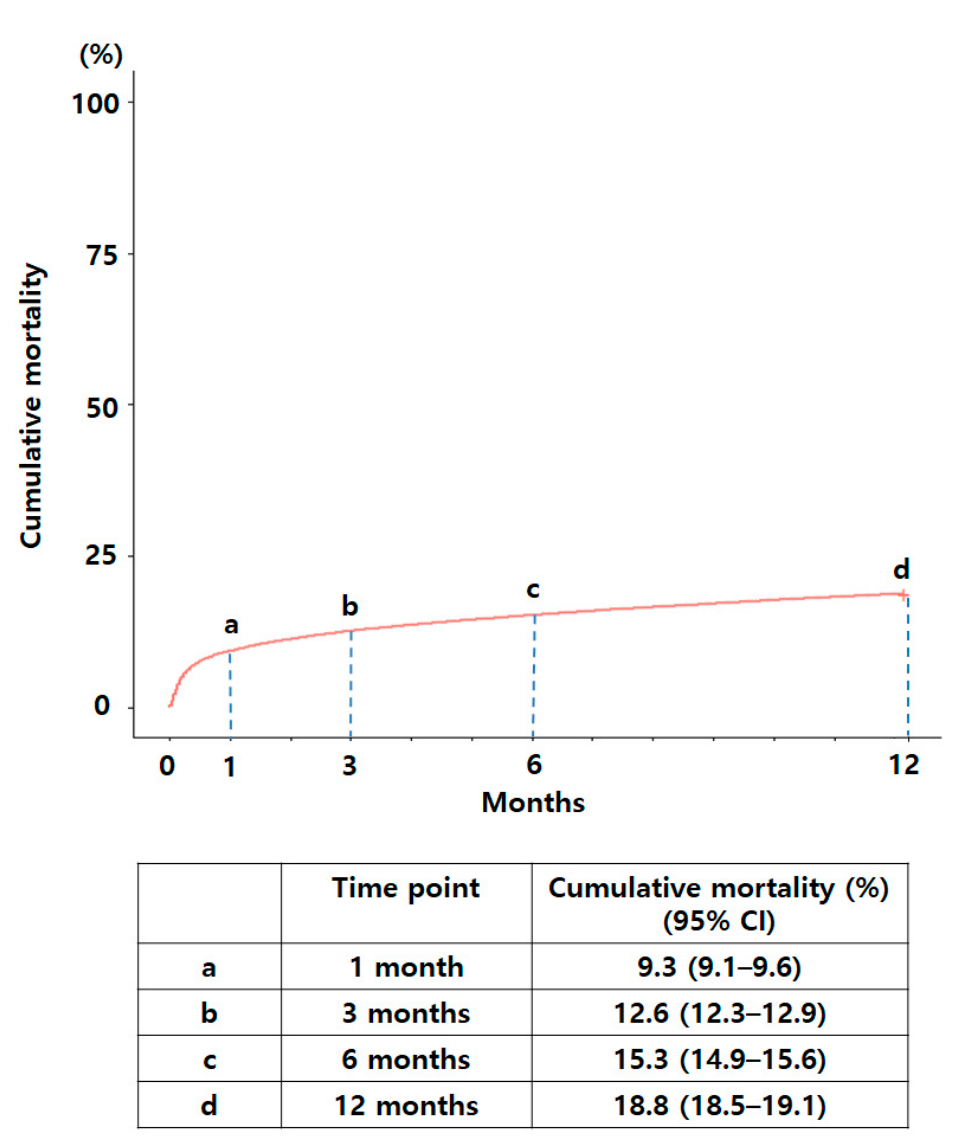
Figure 1. The 1-, 3-, 6-, and 12-month cumulative mortality rates of the total study Figure 1. The 1 ‐ , 3 ‐ , 6 ‐ , and 12 ‐ month cumulative mortality rates of the total study population.